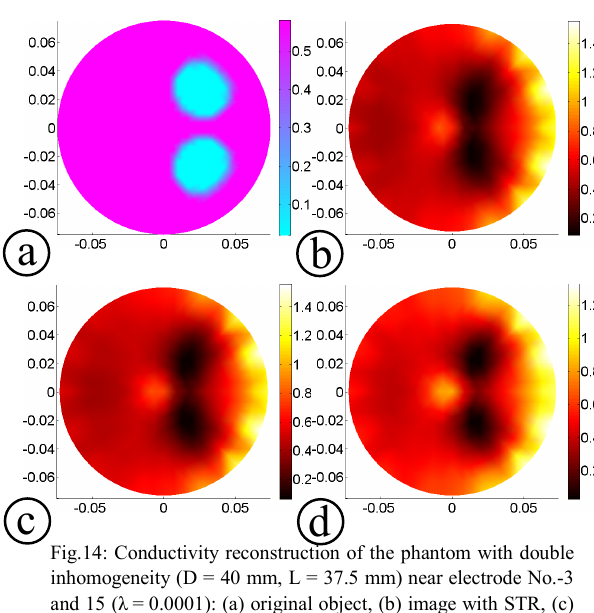
Fig.14: Conductivity reconstruction of the phantom with double inhomogeneity (D = 40 mm, L = 37.5 mm) near electrode No.-3 and 15 ( λ = 0.0001): (a) original object, (b) image with STR, (c) image with LMR, (d) image with BMMR.